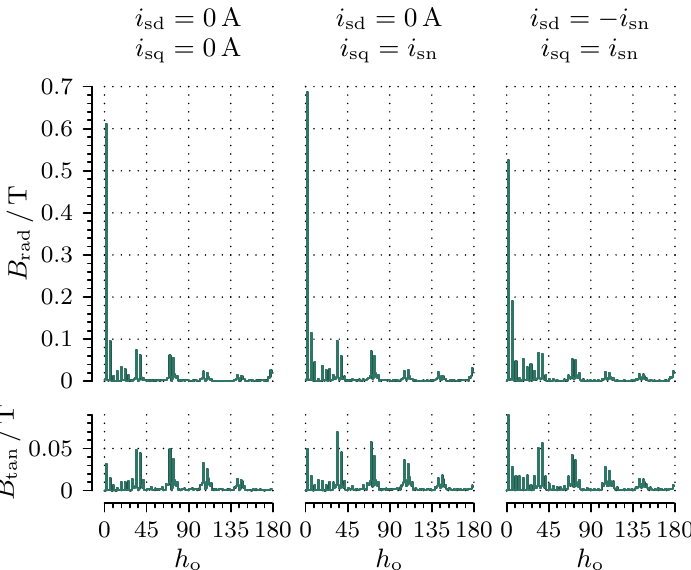
Figure 3. Harmonic spectra of B rad and B tan for a single period of θ m and ϕ e = 0 ◦ at different load